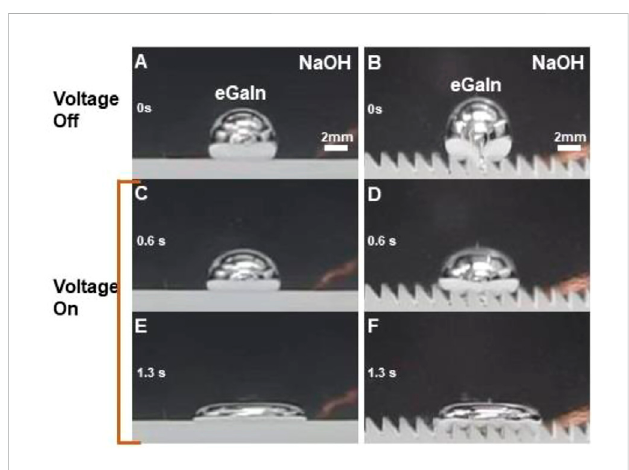
FIGURE 3 Series of snapshots show the cycle of the 100- μ L eGaIn heartbeat on a fl at surface and ratchet substrates with three directions, such as leg, base, and channel directions.